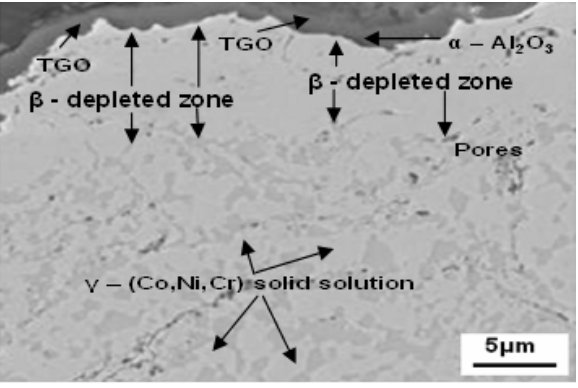
Figure 11 – SEM microphotography of the Co32Ni21Cr8Al0.5Y coating : oxidation at 1100 0 C/240 hours Slika 11 – SEM mikrofotografija Co32Ni21Cr8Al0.5Y prevlake : oksidacija na 1100 0 C/240